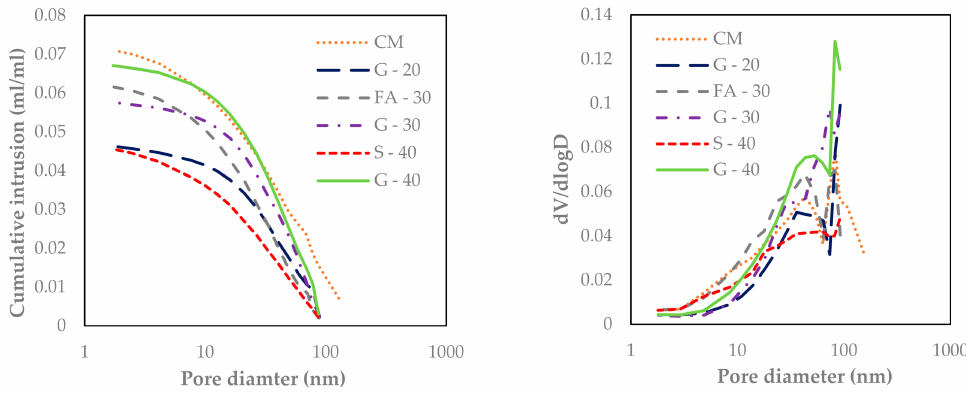
Figure 16. Pore size distribution ( left ) and differential curves ( right ) of cement pastes at 100 days.